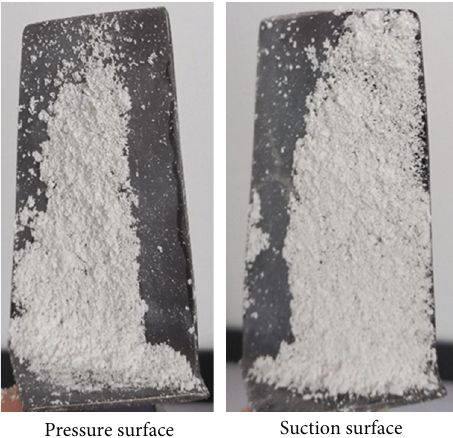
Figure 8: Observation of the surface morphology of the compressor blade surface area.